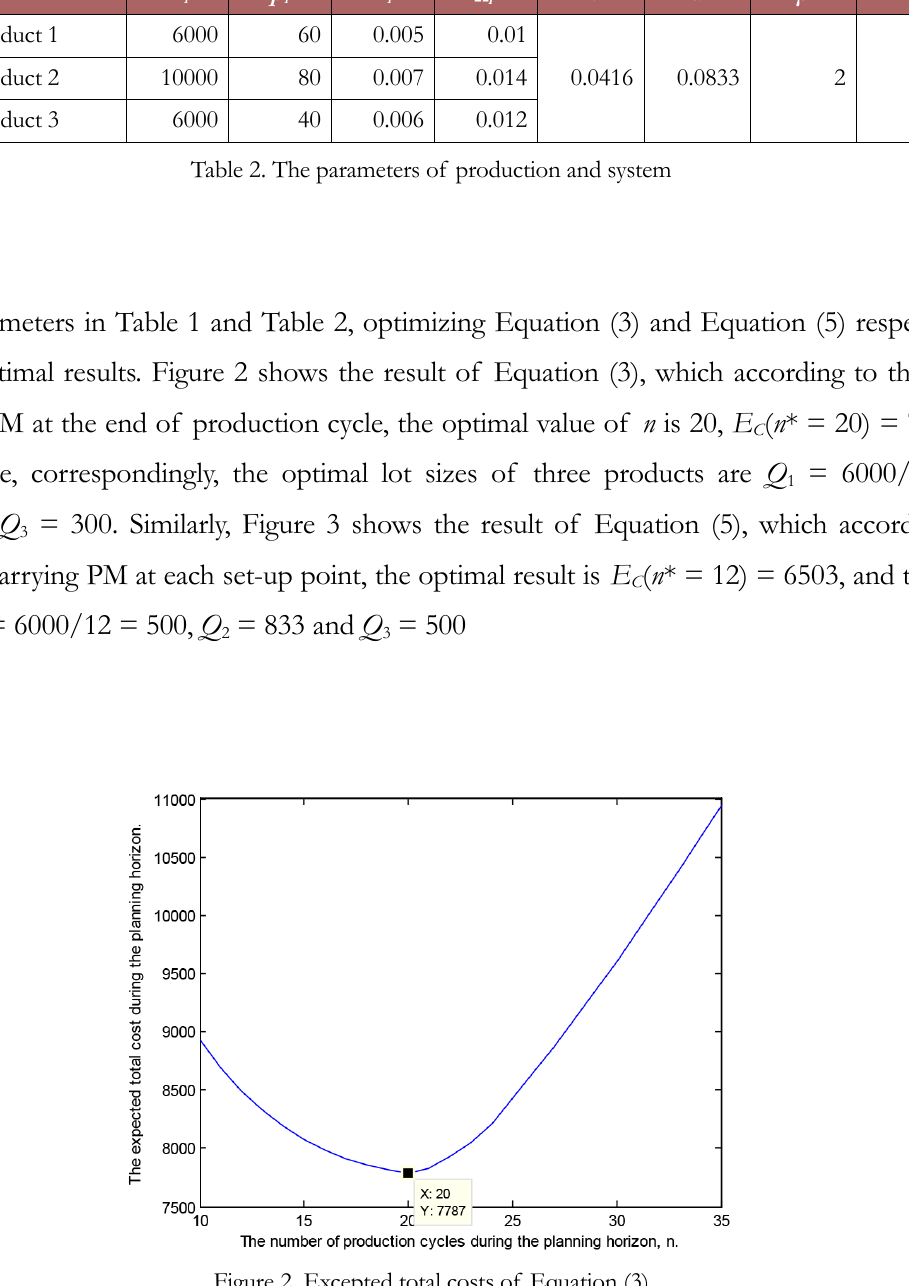
Figure 2. Excepted total costs of Equation